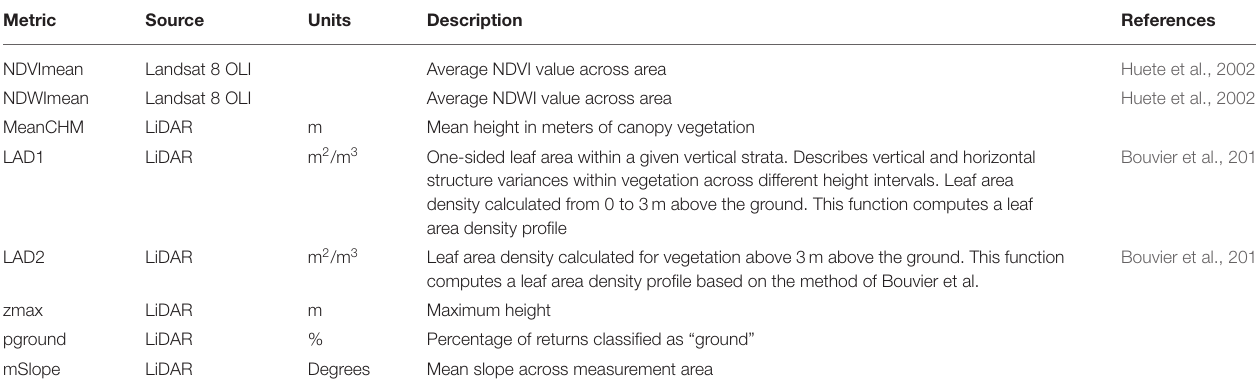
TABLE 1 | Remote sensing variables.